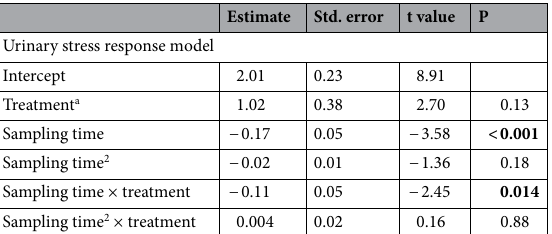
Estimate Std. error t value